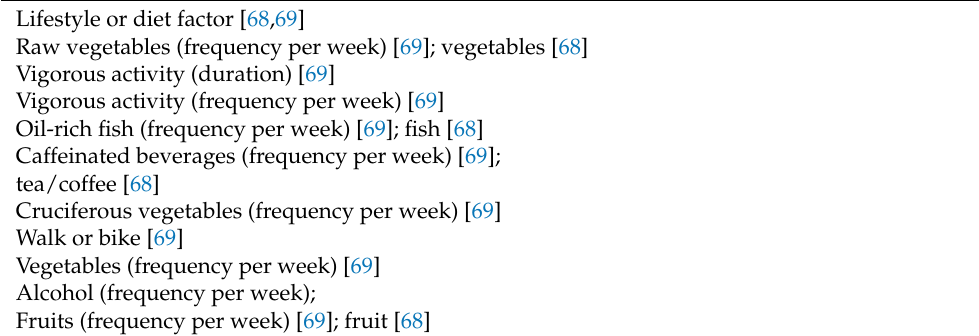
Table 1. Lifestyle and diet factors associated with gut microbiome